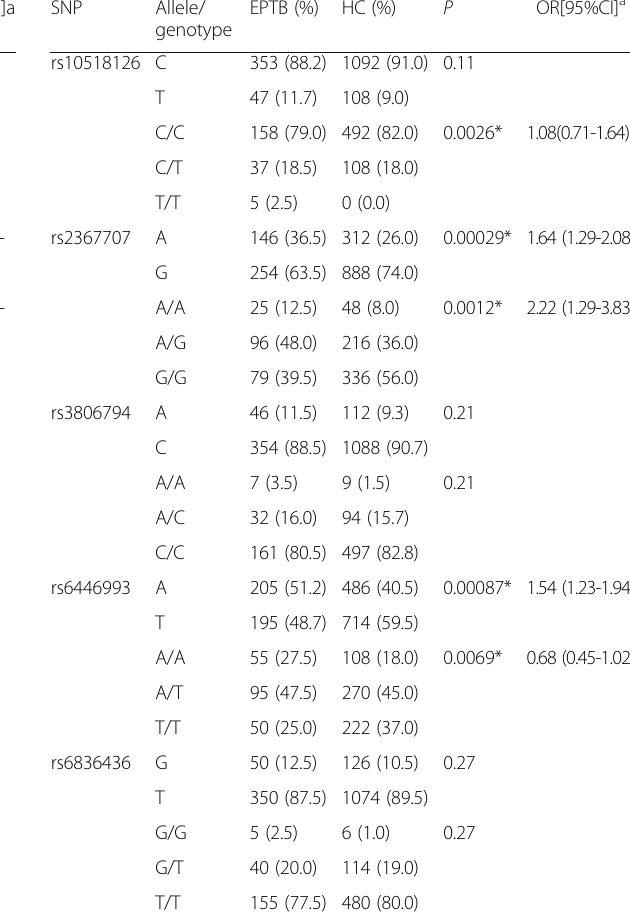
Table 4 Allele and genotypic frequencies of EREG SNPs in the